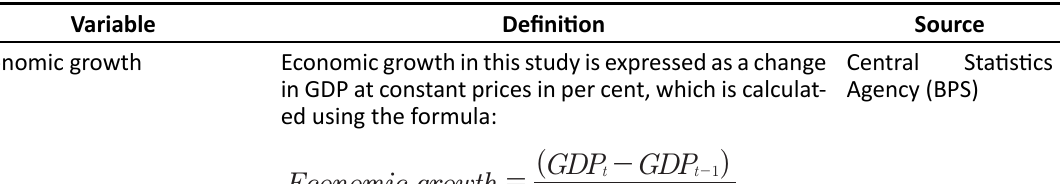
Table 1: Variable, Definition, and the Source of Data